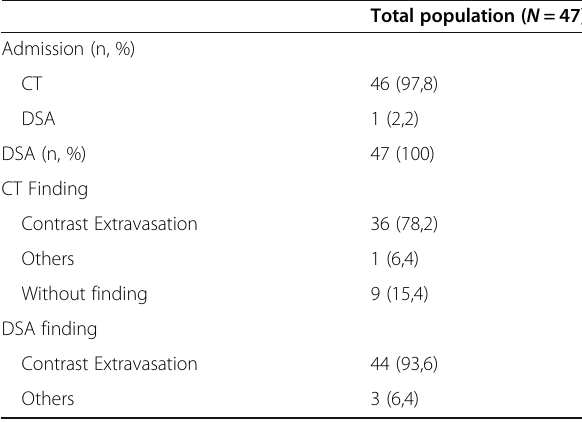
Table 2 Imaging